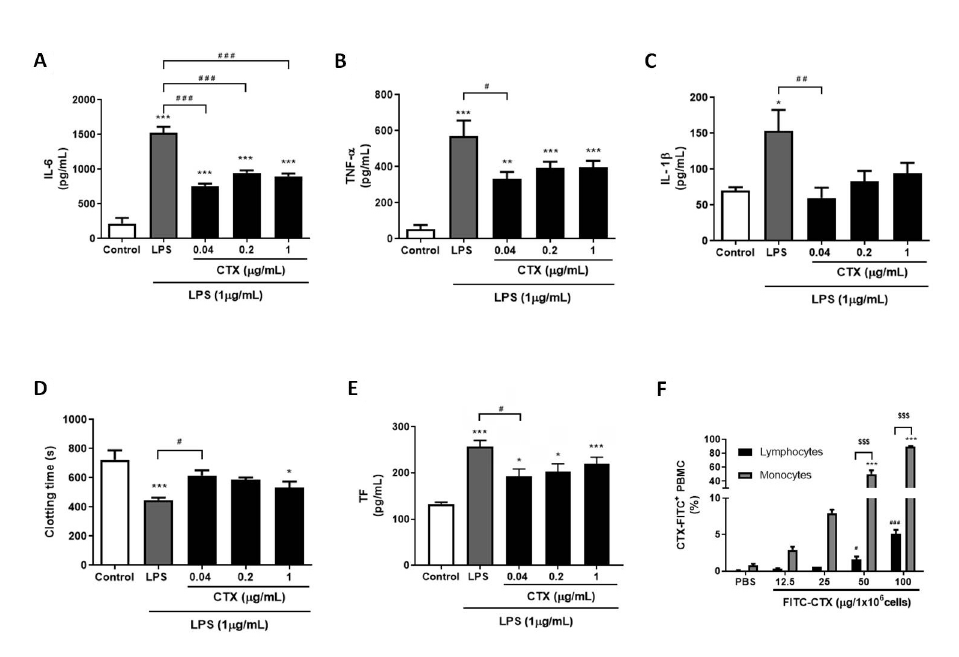
Figure 4. Anti-inflammatory, anticoagulant and cell binding behavior of CTX on PBMC. PBMC treated with medium only (control), LPS (1 µg/mL) or different concentrations of CTX (1, 0.2 or 0.04 µg/mL) 30 minutes before LPS addition, for 24 hours. From the cell supernatant, the pro-inflammatory cytokines (A) IL-6, (B) TNF-α and (C) IL-1β were quantified, and the remaining cells were submitted to the (D) procoagulant activity assay or cell lysate for (E) TF quantification. Results were expressed as mean cytokine concentration (pg/mL) ± SEM, mean clotting time (s) ± SEM and mean TF concentration (pg/mL) ± SEM. Experimental groups were performed with n = 6. ***p < 0.001, **p < 0.01 and *p < 0.05 vs. control, and ### p < 0.001, ## p < 0.01 and # p < 0.05 vs. LPS. (F) The cell binding was evaluated by flow cytometry from PBMCs incubated with PBS only or FITC-CTX conjugate (12.5-100 µg/mL). The result was expressed as mean of FITC- CTX + populations of monocytes and lymphocytes (%) ± SEM. Experimental groups were performed with n = 3. ***p < 0.001 vs. PBS (monocytes), ### p < 0.001 and # p < 0.05 vs. PBS (lymphocytes) and $$$ p < 0.001 monocytes vs. lymphocytes (Student’s t-test). Statistical analysis was performed using one-way ANOVA followed by Dunnett’s